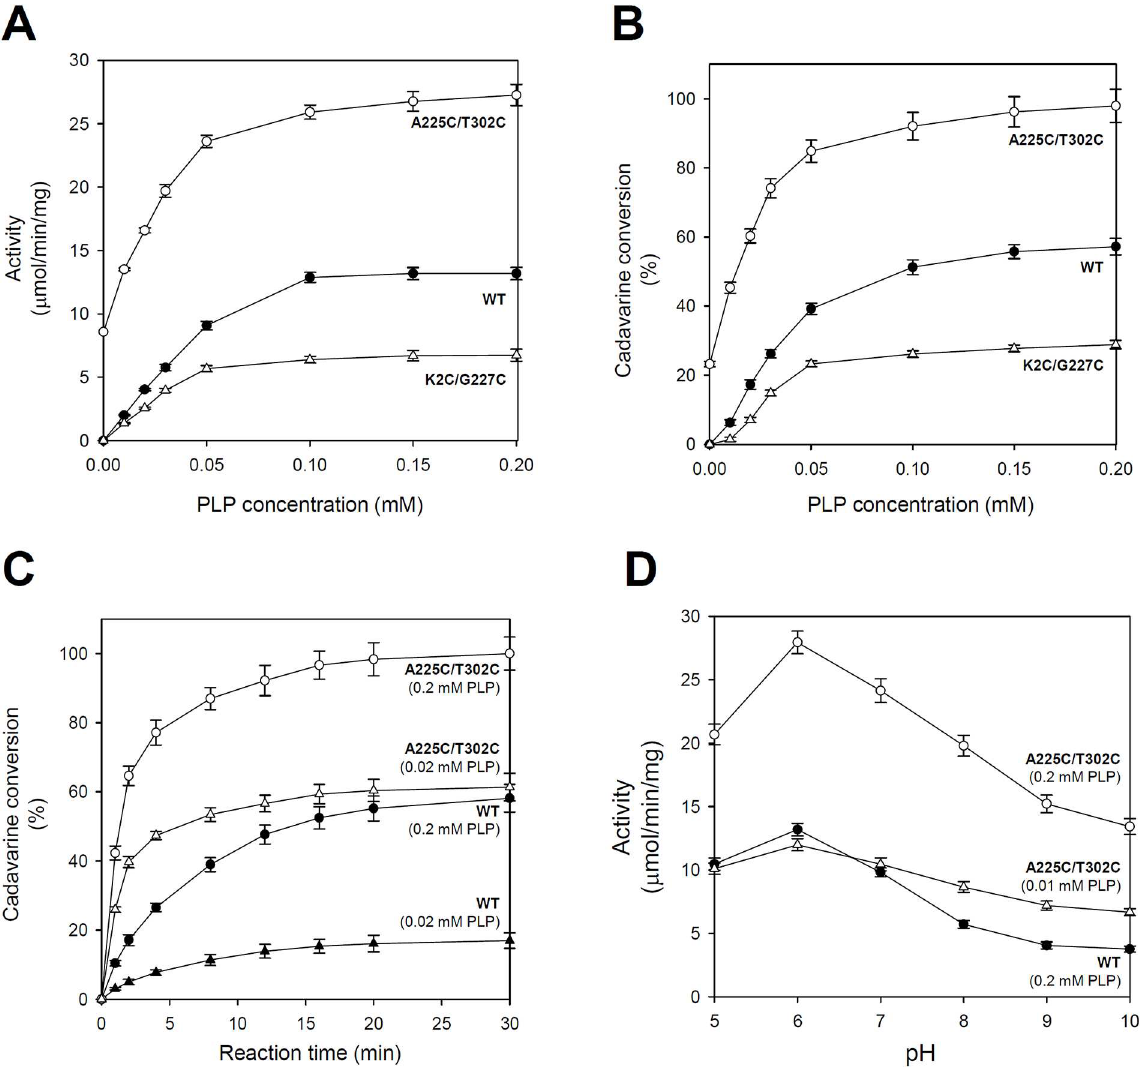
Fig 3. Comparison of LDC activity between Sr LDC proteins ( A ) Comparisonof LDC activitiesof the Sr LDC proteins. LDC activitiesof Sr LDC WT , Sr LDC K2C/G227C , and Sr LDC A225C/T302C are measuredat variousconcentrations of PLP. ( B ) Comparisonof cadaverine conversionof the Sr LDC proteins. Cadaverine conversionof Sr LDC WT , Sr LDC K2C/G227C , and Sr LDC A225C/T302C are measuredat variousconcentrations of PLP. ( C ) Comparisonof time-course cadaverine conversionbetween Sr LDC WT and Sr LDC A225C/T302C . Time-course cadaverine conversionof Sr LDC WT and the Sr LDC A225C/T302C mutant are measuredunder PLP concentrations of 0.02 and 0.2 mM. ( D ) Comparisonof resistanceto pH between Sr LDC WT and Sr LDC A225C/T302C . The LDC activity of Sr LDC WT is measuredat pH from 5 to 10 under 0.2 mM PLP. The LDC activities of the Sr LDC A225C/T302C mutant are also measuredat the same pH range under 0.01 and 0.2 mM